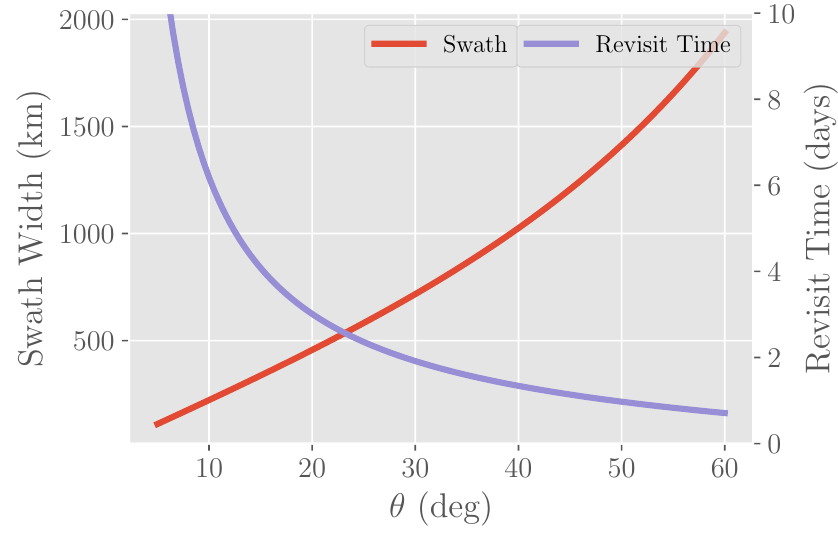
Figure 8. Swath width (left axis) and revisit time (right axis) as a function of incidence